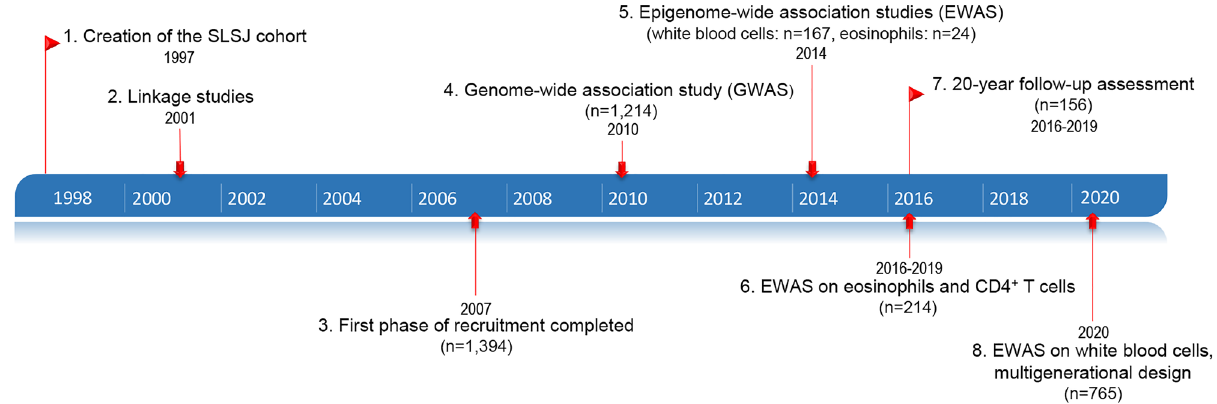
Figure 1. Timeline of the SLSJ asthma family cohort. Stages in the acquisition of phenotypic, genomic, and epigenomic data for the SLSJ family cohort. Description of approaches used at each stage: 1.–3. Standardized questionnaire, respiratory measurements, blood samples (IgE, differential white blood cell counts, and DNA), 2. Microsatellite markers, 4. Illumina 610 K-Quad chip, 5. Infinium Human Methylation 450 K chip (white blood cells and eosinophils), 6. Isolation of naive CD4 + T cells and eosinophils for DNA and RNA extraction for methylome and transcriptome (methylome sequencing with custom methyl capture panel [MCC-Seq] and RNA sequencing), 7. Standardized questionnaire, respiratory measurements, blood samples (IgE, differential white blood cell counts, DNA, RNA, and plasma), 8. MCC-Seq (white blood cells). Between 2001 and 2010, candidate gene studies were performed with genetic variants, expression, and methylation